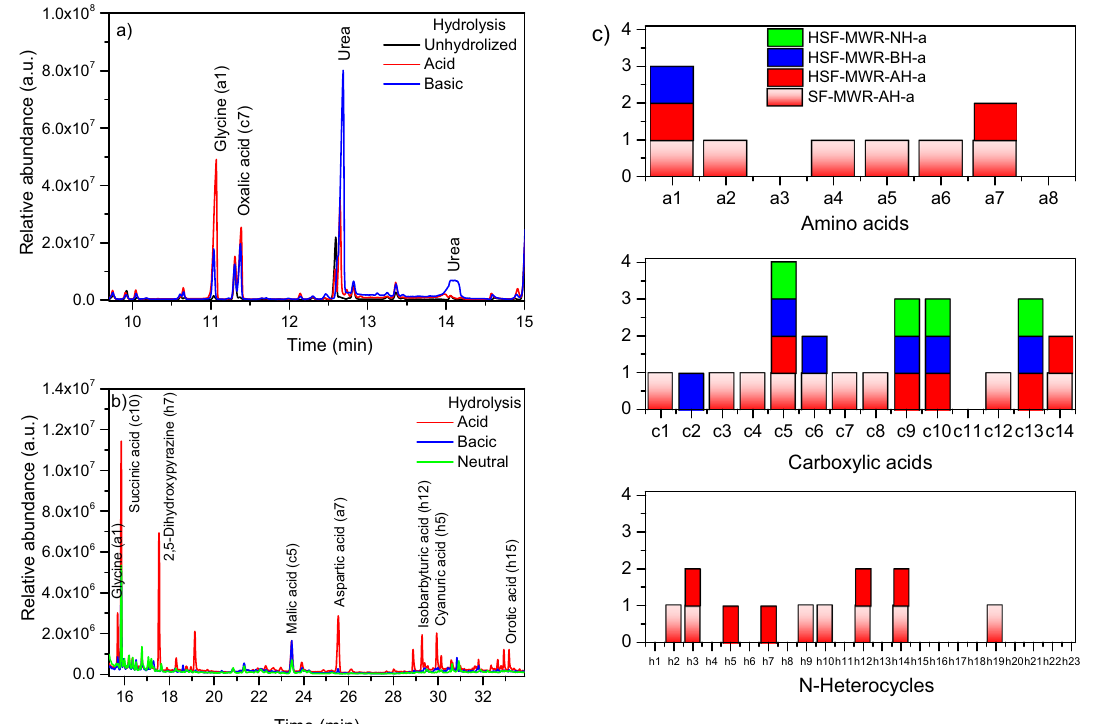
Figure 6. SF = sol fraction; HSF = heavy sol fraction (> 3 kDa); MWR = microwave radiation; AH = acid hydrolysed sample; BH = basic hydrolysed sample; NH = neutral hydrolysed samples; a = GC–MS method (please see the experimental section). ( a ) and ( b ) GC–MS profiles of a representative heavy sol fraction hydrolysed using several conditions. Note that the intensity of the peaks in (b) is much lower than that in (a). For this reason, the GC–MS chromatograms have been shown in two parts for a better view of the identified compounds. Only the analytes identified at a higher concentration are named. ( c ) Qualitative comparative analyses of several samples. The letter and number shown in the axis correspond to the analyte numeration indicated in Fig.